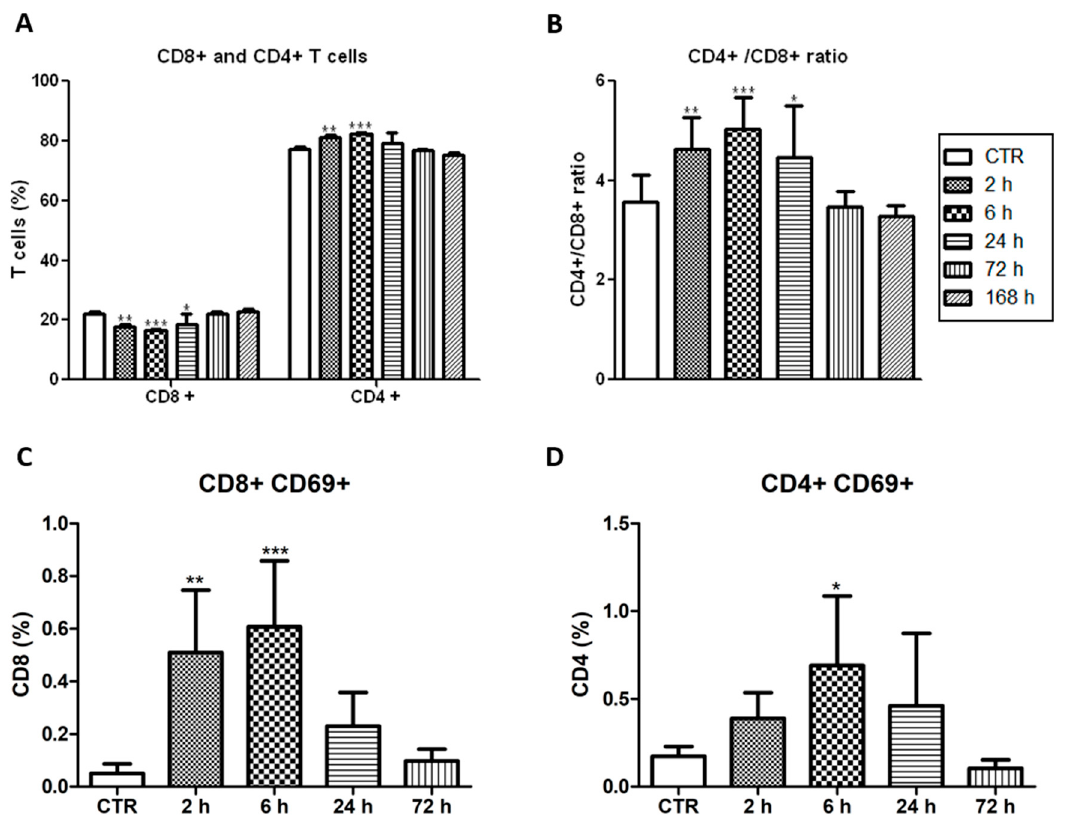
Figure 3. Activated T cells after vascular-PDT with redaporfin. ( A ) Percentage of CD4 + and CD8 + T cells and ( B ) ratio of CD4 + /CD8 + T cells in the blood of mice at different time points after vascular-PDT. ( C ) Percentage of CD8 + or ( D ) CD4 + T cells expressing CD69 in the blood of mice at different time points after PDT. Bars are the mean ± SD of five mice. No symbol: p > 0.05; * p < 0.05; ** p < 0.01; *** p < 0.001.